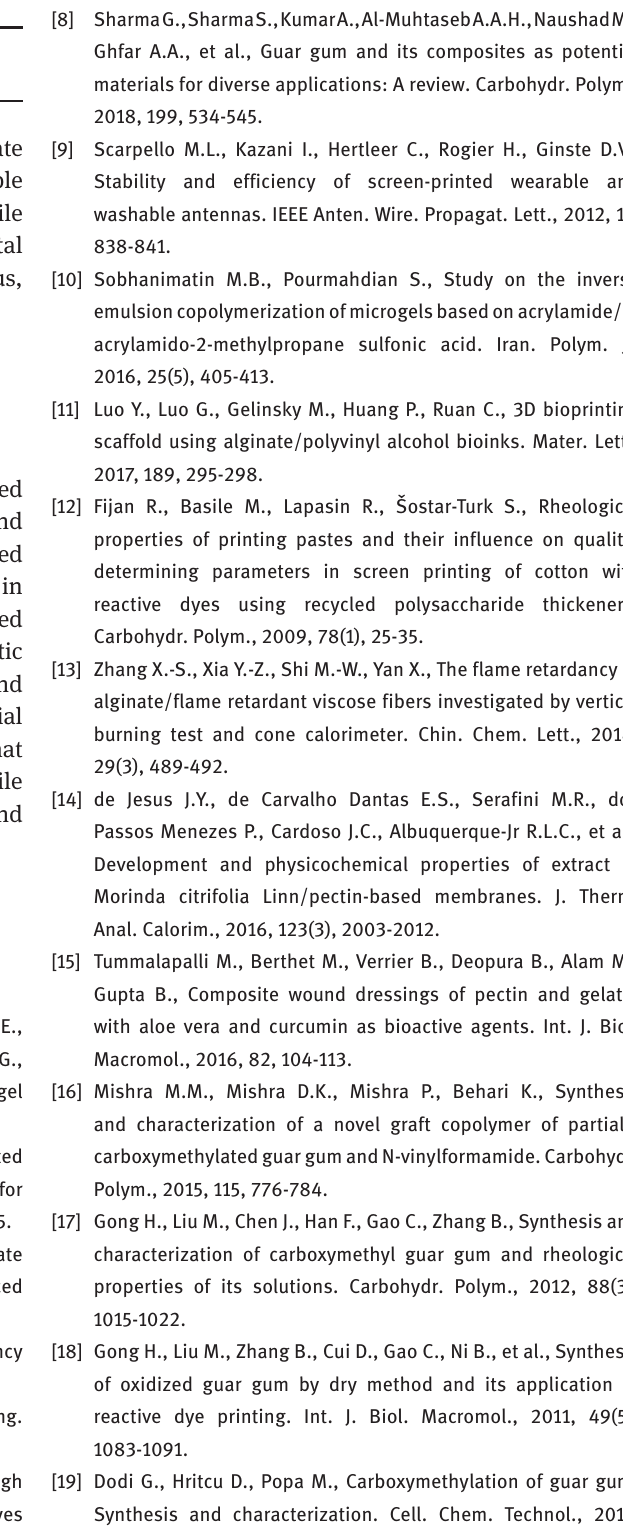
Table 4: Color fastness to washing.